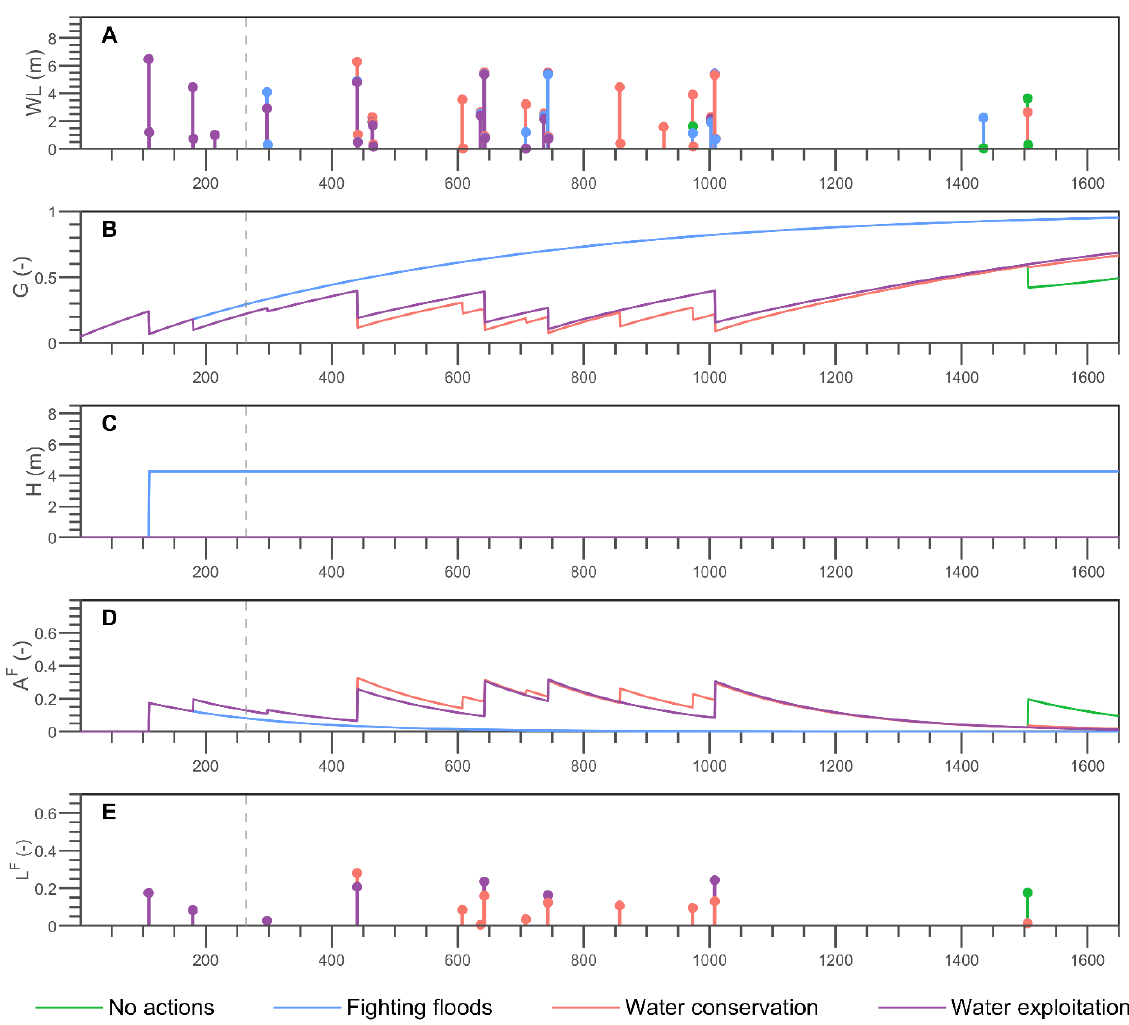
Figure A10. Flooding-based variables of the synthetic experiments additional scenario #1 considering dam construction and human-flood interactions with the four water management strategies introduced in this study. (A) Water level (WL), (B) proportion of population in floodplain (G), (C) levee height (H), (D) flood awareness (AF), and (E) flood losses (LF). The grey dashed line indicates the construction of the Wivenhoe